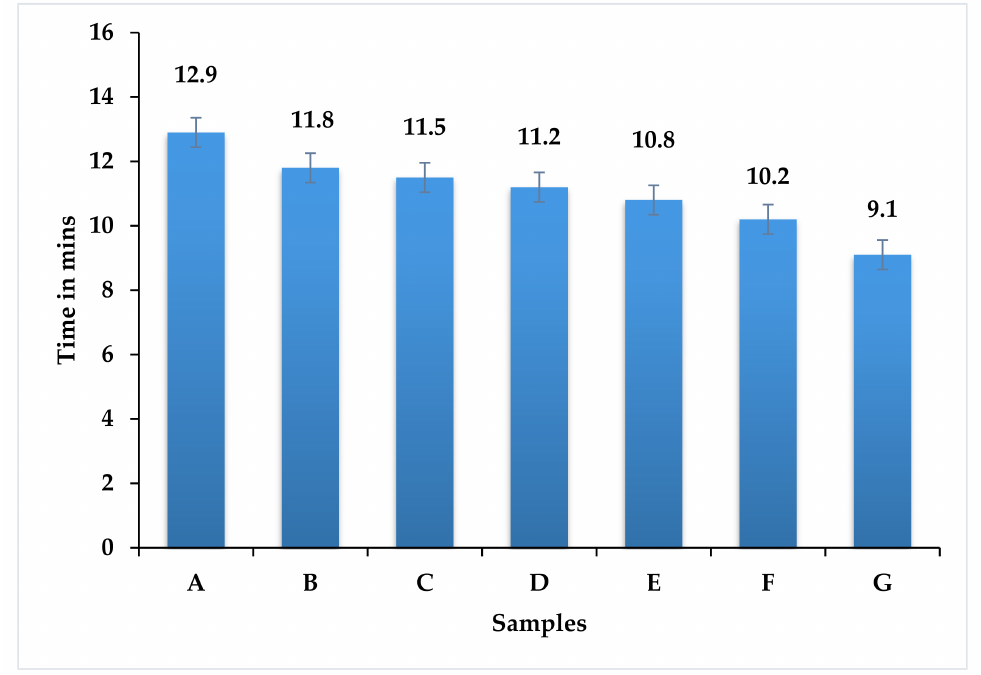
Figure 9. Flame retardant effect of hybrid epoxy